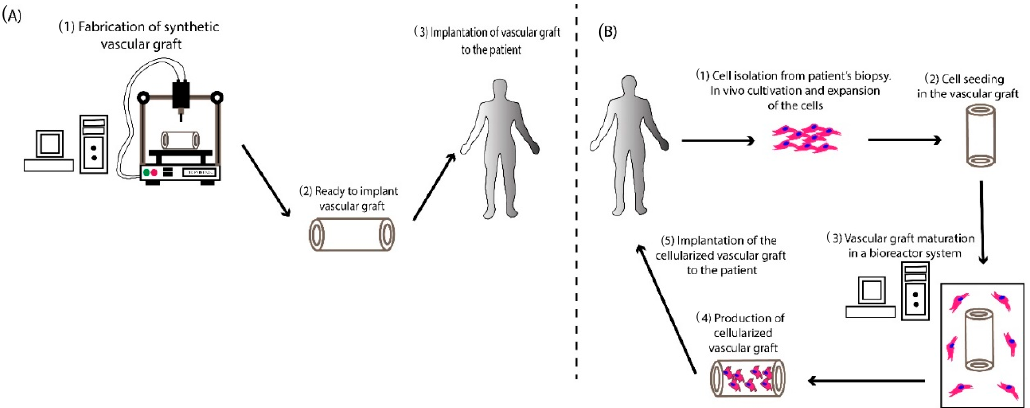
Figure 1. Development and implantation of engineered small-diameter vascular grafts (SDVGs). ( A ) The first approach comprises the production of acellular SDVG derived from polymer materials using the state-of-art bioprinting approach. Then, the manufactured SDVG can be implanted immediately into the patient. In this approach, the patient’s body will serve as a bioreactor for the recellularization of the implanted vascular graft. However, some major disadvantages, including the time period needed for the proper cellularization or the impaired functionality of the produced vascular grafts, maybe existed. ( B ) The second approach comprises the combination of cellular populations with the polymer derived SDVGs. In this approach, the cells can be isolated from the patient’s tissue biopsy, in vitro expanded, and seeded onto the SDVG. Finally, the engineered SDVG can be implanted back to the patient. The advantage of this approach is the production of compatible SDVGs with the patients, avoiding in this way any potential adverse reactions.